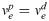
Accuracy of the analytical estimate for the properties of the membrane potential fluctuations at the soma: Comparison between numerical simulations and the analytical approximation.Shown for the medium size model of Fig 2D. (A) In the numerical simulation, we explicitly simulate the whole dendritic arborescence, we show the membrane potential variations for the three locations shown on the left. (B) Properties of the membrane potential fluctuations (mean μV, standard deviation σV and autocorrelation time τV) for different configuration of presynaptic activity: analytical predictions and output from numerical simulations in NEURON. In each column, one variable is varied while the other variables are fixed to the mean configuration value corresponding to νep=νed = 0.2Hz, νip=νid = 1.2Hz and s = 0.05. In the σV plots (middle panels, dashed gray lines), we added the prediction of the analytical estimate after a +0.18 correction for the synchrony (found with a Newton method).